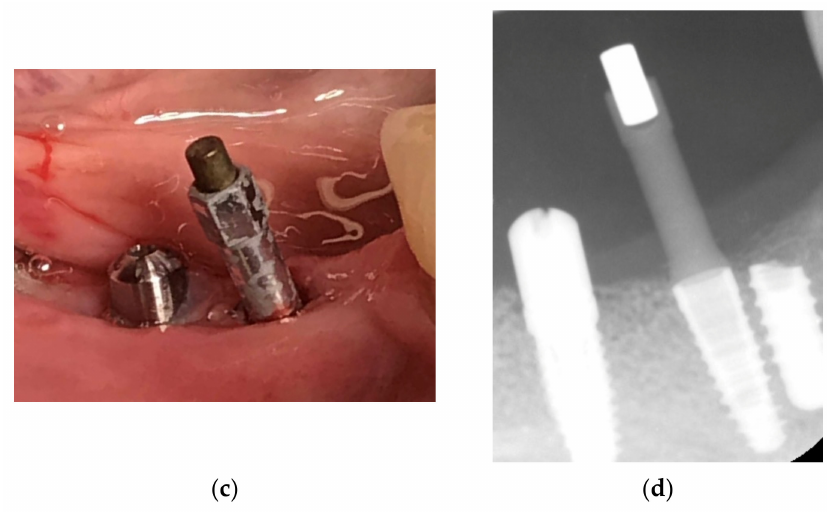
Figure 18. Stability ISQ measurements ( a – d ).